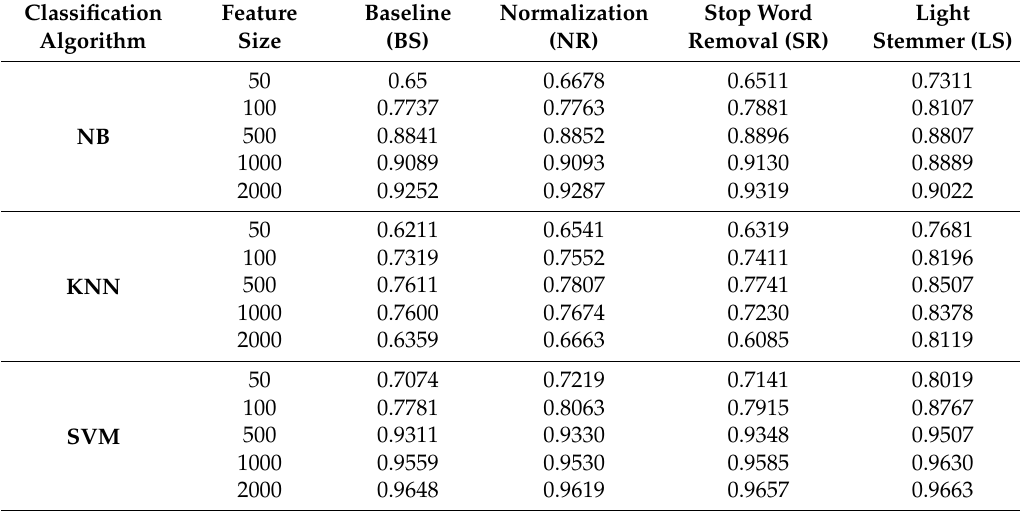
Table 5. F1 Measure scores for preprocessing tasks when applied individually.